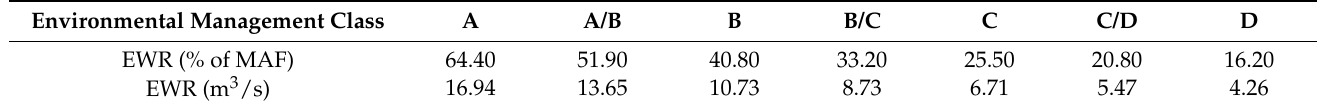
Table 9. Estimation of EWR for different environmental management classes using the desktop reserve model (DRM) method, Kor